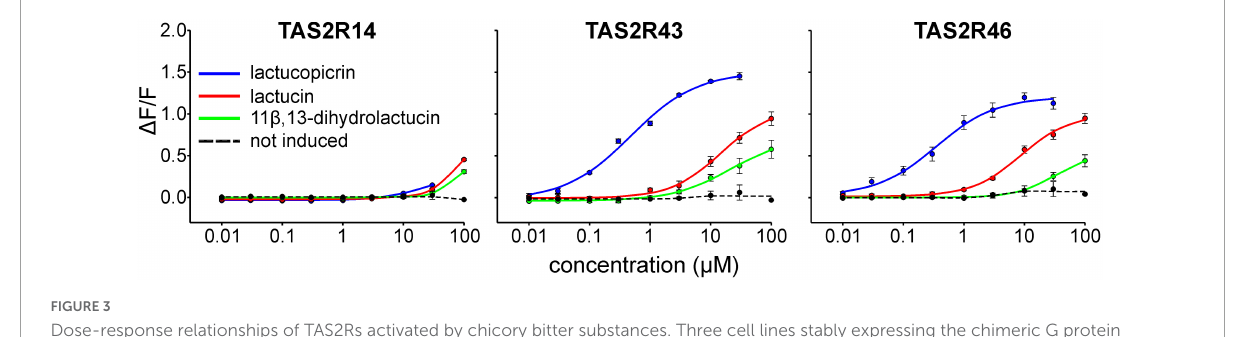
FIGURE3 Dose-response relationships of TAS2Rs activated by chicory bitter substances. Three cell lines stably expressing the chimeric G protein G α 16gust44 as well as receptors TAS2R14, TAS2R43, or TAS2R46 (tetracycline-inducible) were subjected to calcium mobilization assays. Administration of lactucopicrin (blue curves), lactucin (red curves) and 11 β , 13-dihydrolactucin (green curves) and measurement of fluorescence changes were done using a fluorometric imaging plate reader (FLIPR tetra ). For negative controls, non-induced cells were challenged with the test compounds and responses shown as averaged curve (dotted, black). Relative changes of fluorescence ( (cid:49) F/F) are plotted on the y -axis. Concentrations of applied test compounds in µ M are indicated at the logarithmically scaled x -axes.